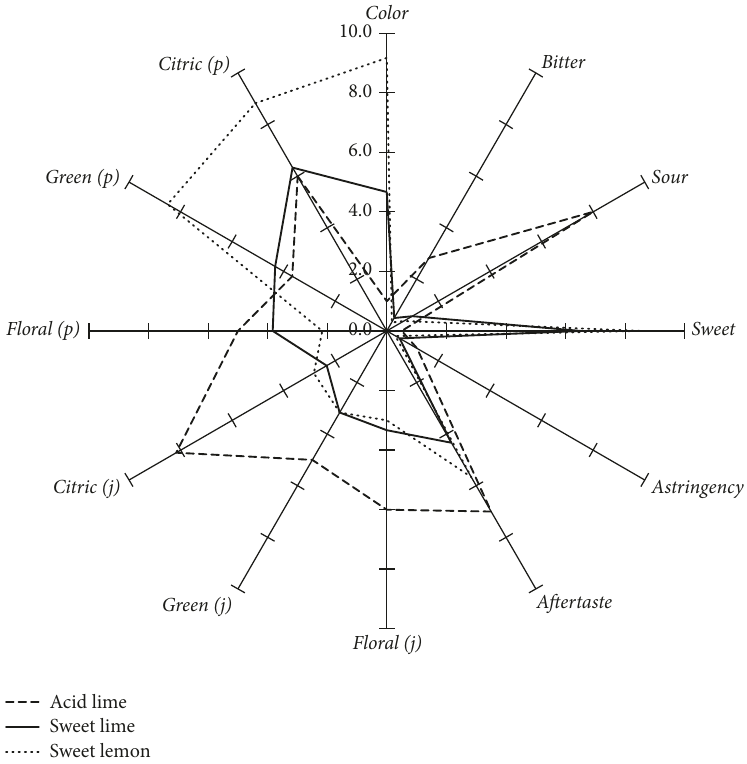
Figure 2: Descriptive sensory analysis (DSA) of flavor attributes in endangered Spanish lime and lemon samples (j: juice, p: peel) .